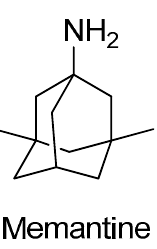
Figure 4. Structure of the clinically approved NMDAR antagonist. Nevertheless, over the years, numerous studies reported the design of novel ac- tive NMDAR antagonists using in silico methodologies [9]. For instance, Ivanova and co-workers used a virtual screening approach to discover new potential NMDAR an- tagonists [36]. Using a combination of various machine learning methods, including artificial neural networks and advanced multilinear techniques to build QSAR models, they screened over 13,000 natural compounds and ranked them based on their predicted affinity towards the target (PDB#5TP9) [36]. The best candidates were also analysed by docking and molecular dynamics simulations to identify essential structural moieties that could serve as basis for the design and development of novel and improved NMDAR antagonists [36]. A distinct strategy was carried out by Sharma et al. using pharma- cophore modeling and a four-phased virtual screening study to identify potential drug candidates [37]. The pharmacophore model was generated and validated with a library of 40 known NMDAR antagonists, followed by screening, where the compounds were sorted based on the Lipinski’s rules and in terms of affinity towards the target [37]. Additionally, the hits were submitted to a docking analysis to fully validate the used methodology [37]. The main residues in the NMDAR active site are His88, Ser114, Thr116, Art121, Gly172, Ser173, Thr174, and Tyr214, of which the predicted compound HTS 00987 (Figure 5) in- teracts with His88, Thr174, and Tyr214, while memantine was not predicted to interact with none of these residues, indicating a potential pharmacological interest of this com- pound [37]. Waqar et al. built a homologue model of the 3D structure of NMADR based on the structure of the rat NMDAR (PDB#3JPW) and analyzed by molecular docking the affinity of several conantokins towards this target [38]. Moreover, most of the compounds interacted with residues Gln110 and Glu236, in the NR2B subunit of the NMDAR, and with Ile111, Phe114, and Pro177 by hydrophobic interactions [38]. A similar binding pattern NMDAR antagonists [38]. In another study carried out by Hu and co-workers, the affinity